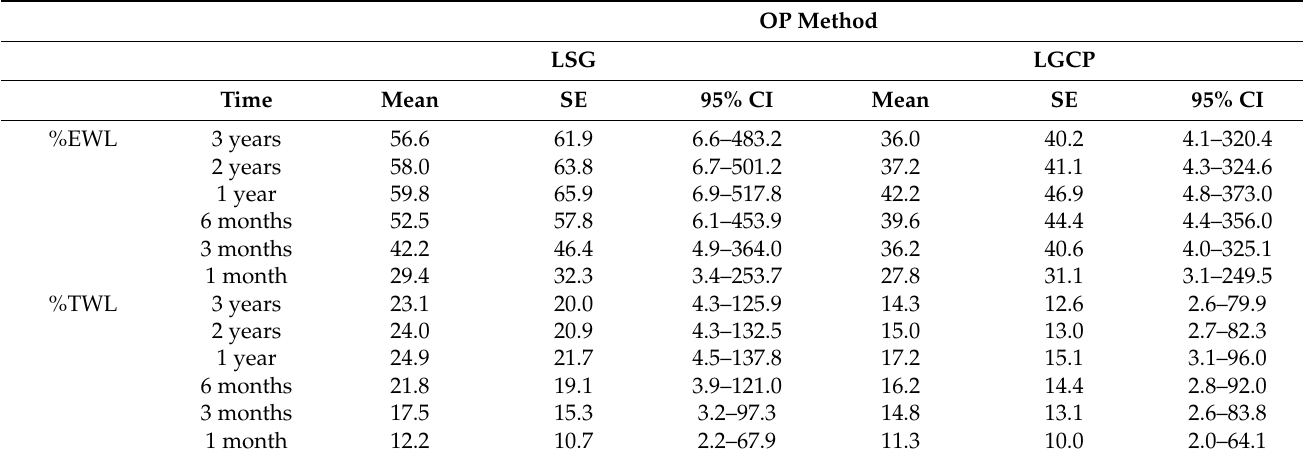
Table 4. Estimated weight reduction rate (%EWL and %TWL) by treatment group for participants in the long-term